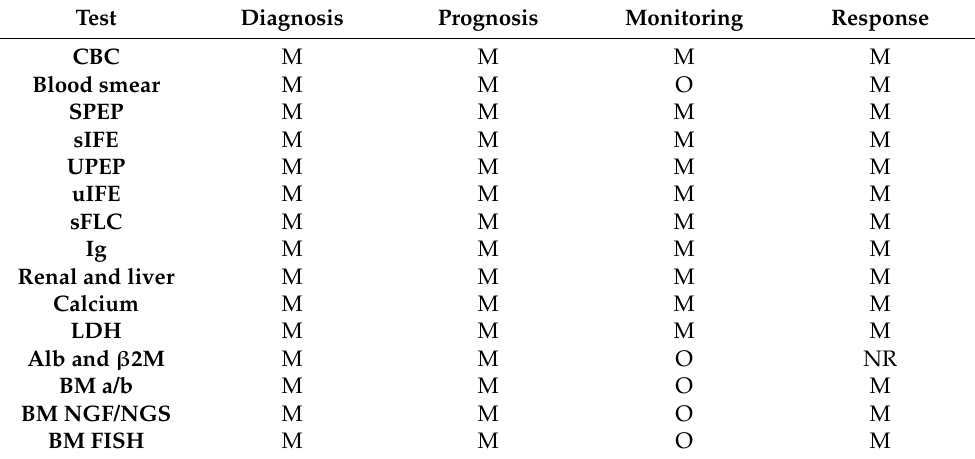
Table 1. Basic laboratory testing in multiple